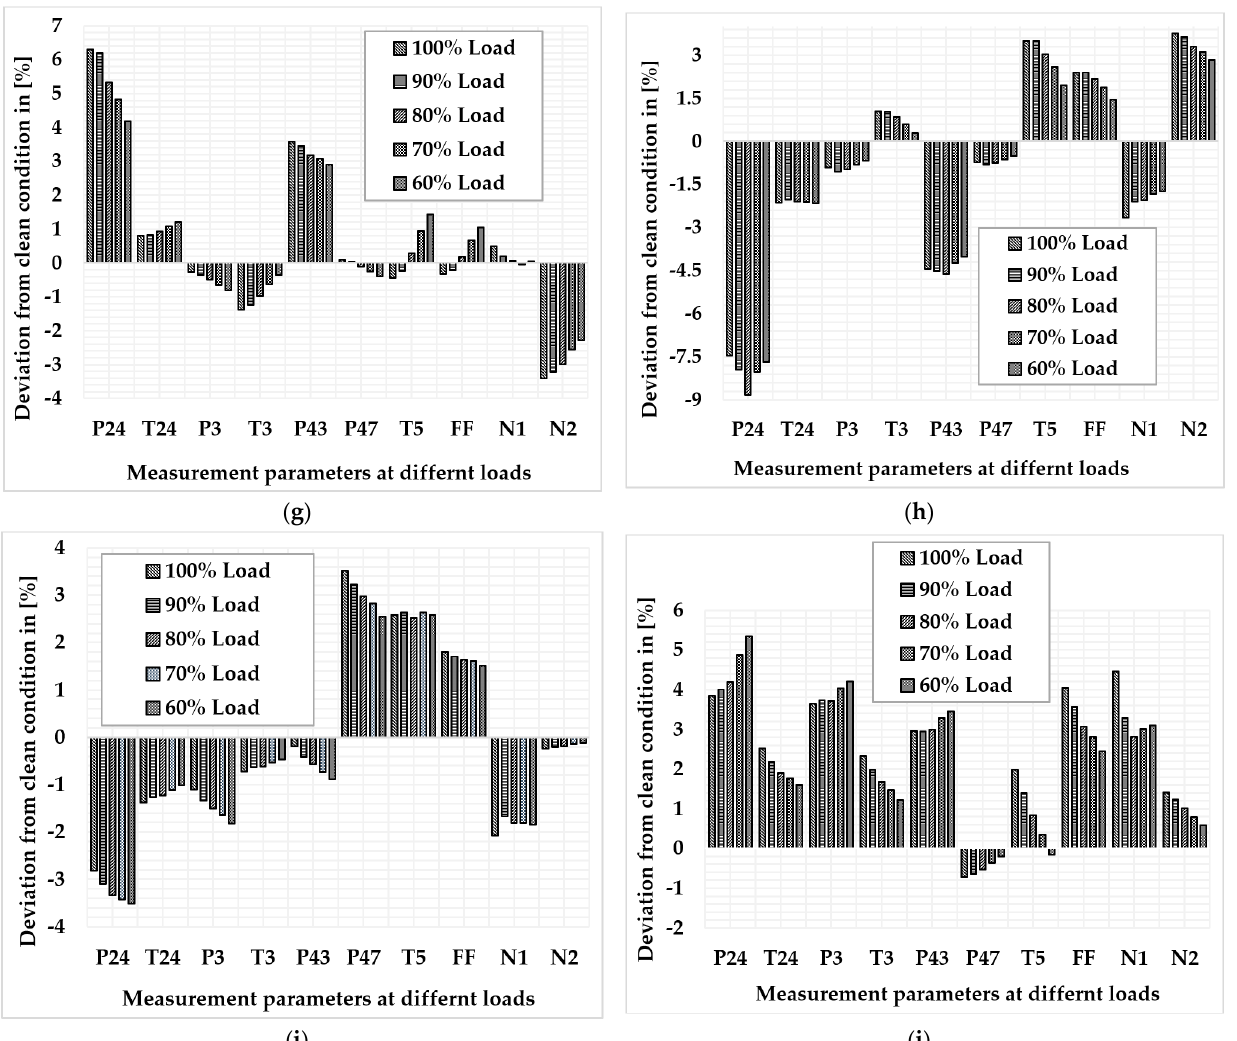
Figure 17. Deviation in measurement parameters due to physical faults at full-load and part-load operation: ( a ) LPC fouling at 100% fault severity, ( b ) LPC erosion at 100% fault severity, ( c ) HPC fouling at 100% fault severity, ( d ) HPC erosion at 100% fault severity, ( e ) HPT fouling at 100% fault severity, ( f ) HPT erosion at 100% fault severity, ( g ) LPT fouling at 100% fault severity, ( h ) LPT erosion at 100% fault severity, ( i ) PT fouling at 100% fault severity, ( j ) PT erosion at 100% fault severity.